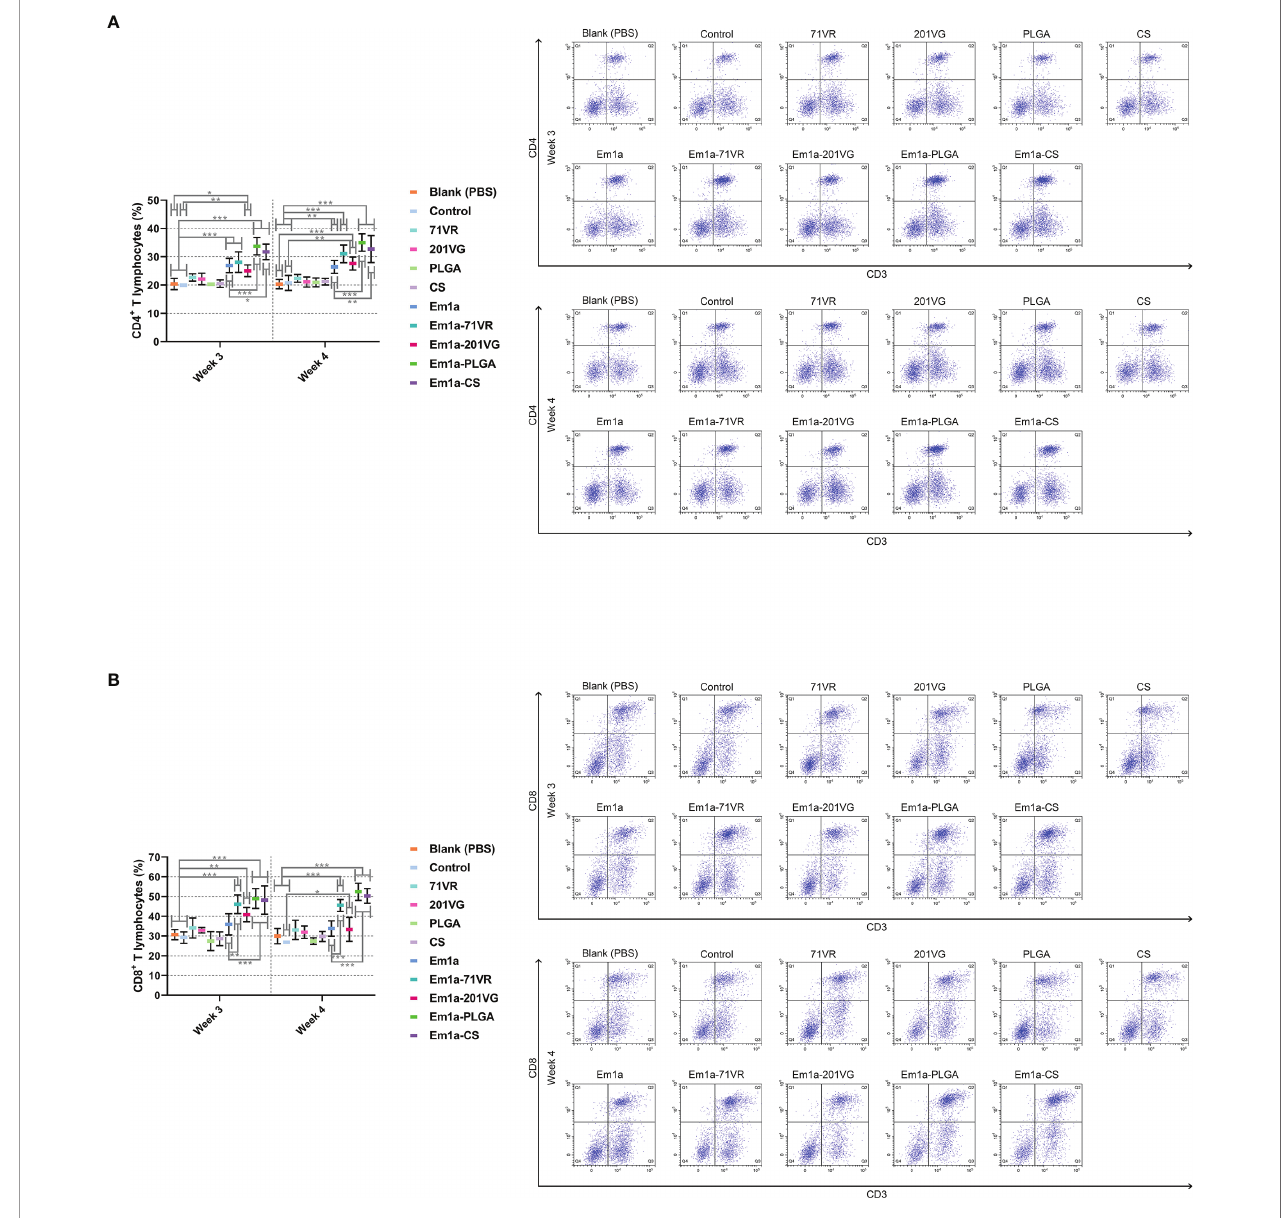
FIGURE 9 | Flow cytometry analysis of CD4 + (A) and CD8 + (B) T lymphocytes in splenocytes at the age 3 and 4 weeks. Chickens from each group were sacri fi ced, and the splenic lymphocytes were harvested. Based on the FMO control, adequate compensation was conducted before cell sorting. Each sample was measured once, and values were estimated using one-way ANOVA followed by Dunnett ’ s test. Comparisons among Em1a, Em1a-71VR, Em1a-201VG, Em1a-PLGA, and Em1a-CS group were conducted by ANOVA following Bonferroni ’ s correction. Values were presented as the mean ± SD (n = 5). In all studies, * p < 0.05, ** p < 0.01, and *** p <